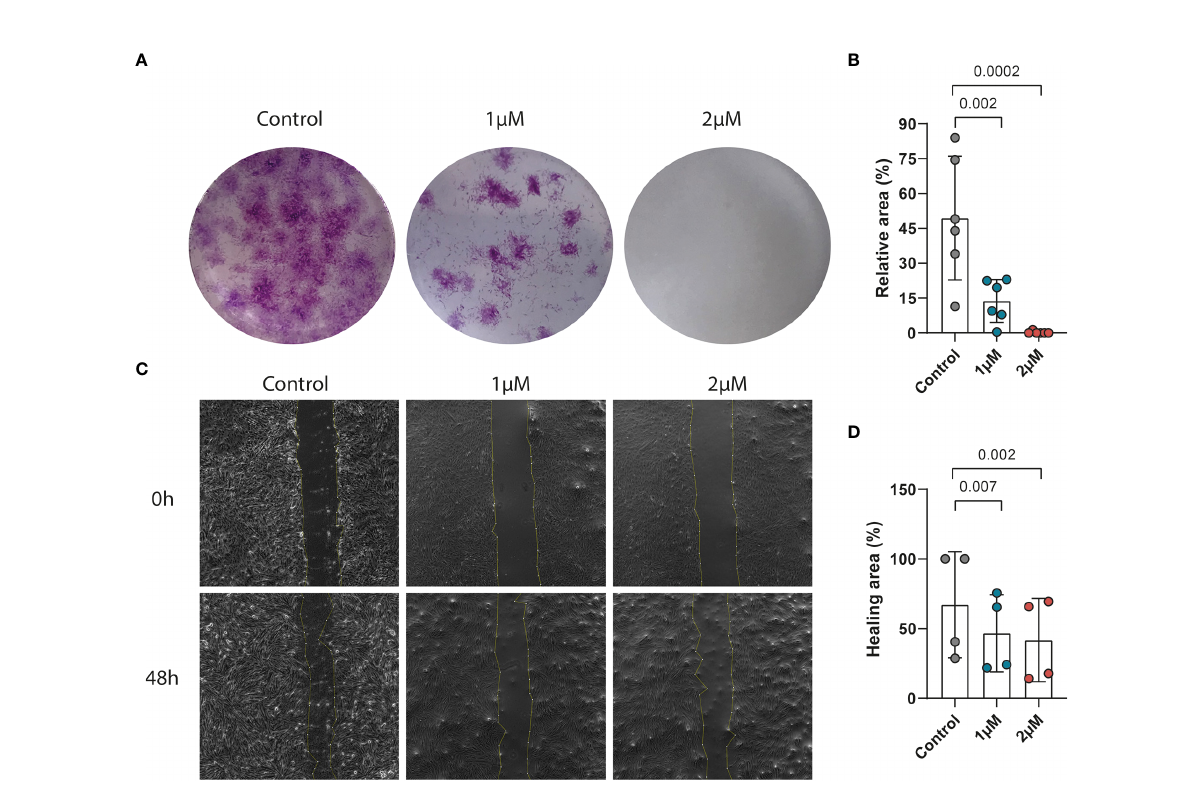
FIGURE 4 PFKFB3 inhibition impaired the migration and proliferation of fi broblasts. Primary fi broblasts were treated with PFK15 (1 m M or 2 m M) and the effects on proliferation and migration were studied. (A) Representative image from the colony formation assay, showing strongly decreased proliferation upon PFKFB3 inhibition. (B) Bar graph represented the statistical results of the relative colony area (n=6 independent fi broblast). (C) Representative phase-contrast microscope images showing the area covered by the cells at 0 and 48 h after wounding, showing decreased wound healing upon PFK15 treatment. (D) Quanti fi cation of the wound-healing assay. The data were normalized to the wound width of each group at 0 h (n=4 independent fi broblasts). One-way ANOVA was